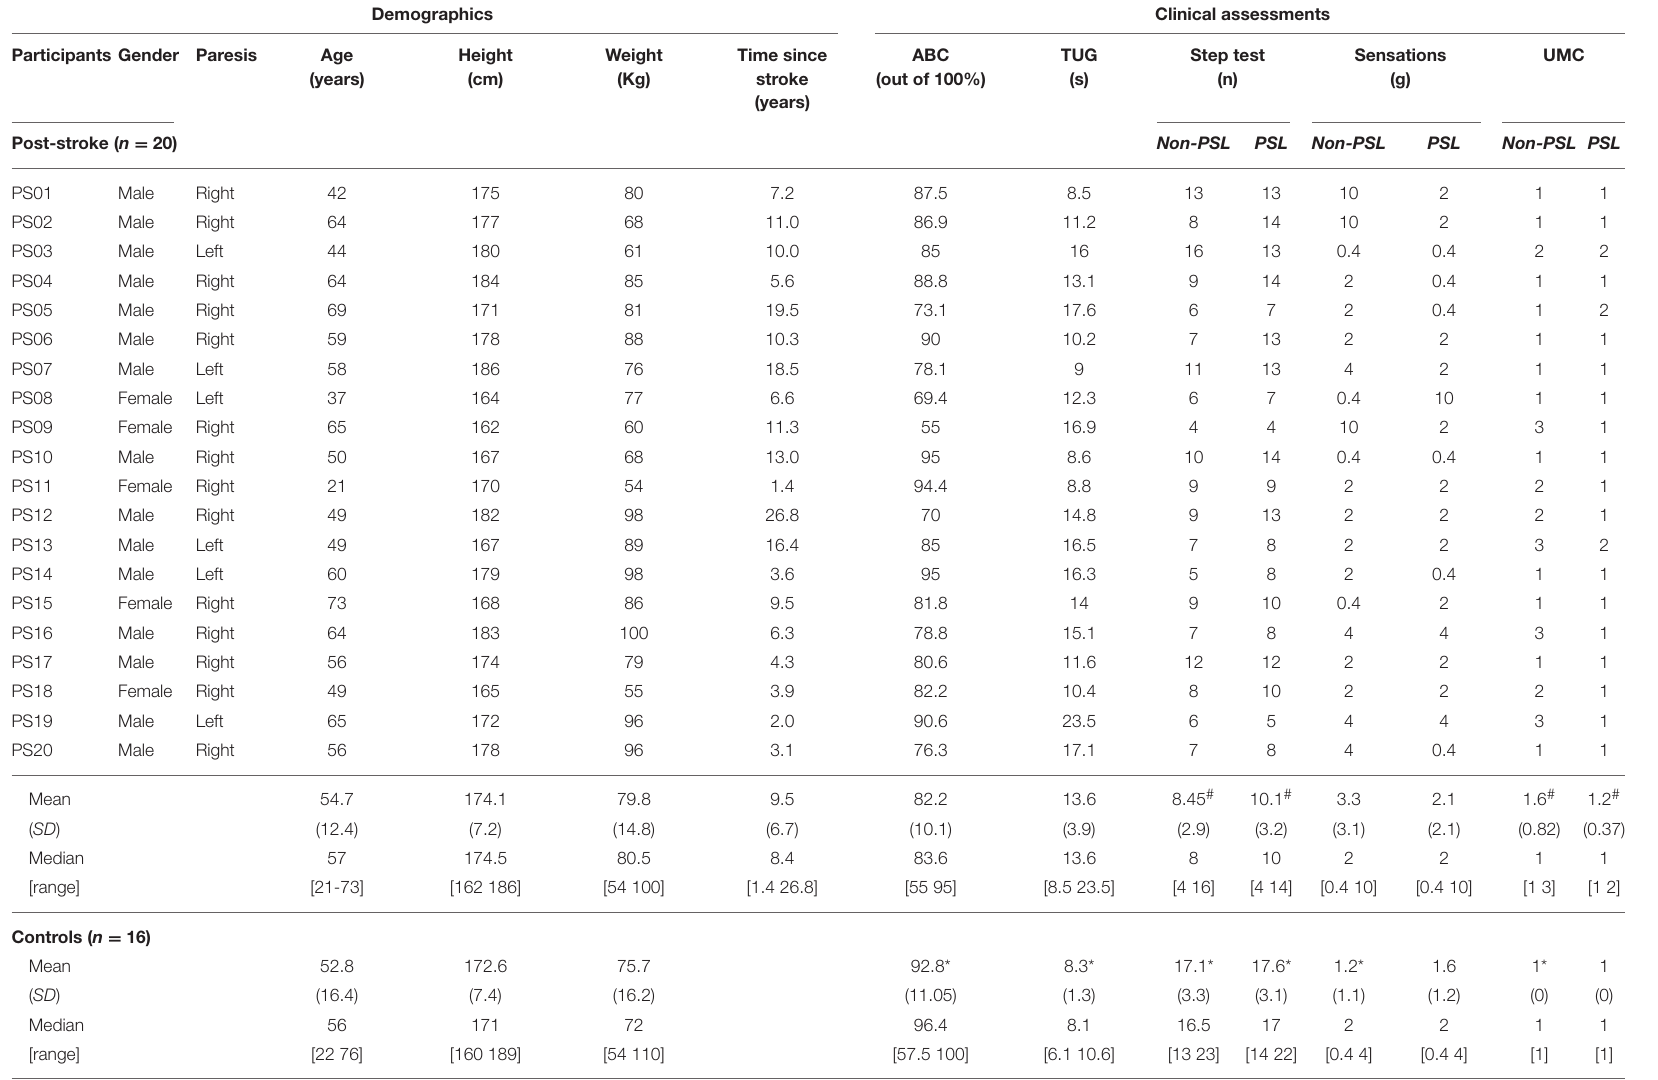
TABLE 1 | Participants